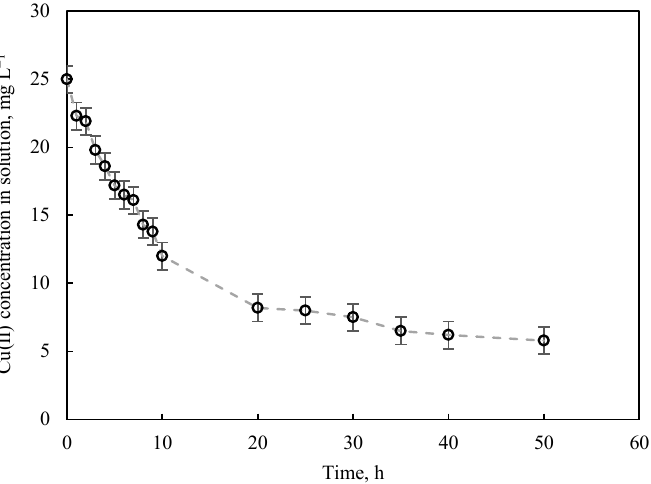
Figure 1. Adsorption kinetics of Cu (II) on marble waste sludges (C 0 = 25 mg L − 1 , 0.1 g of adsorbent, V = 0.1 L at 25 °C, pH = 6). The dashed line is added to assist visualization.